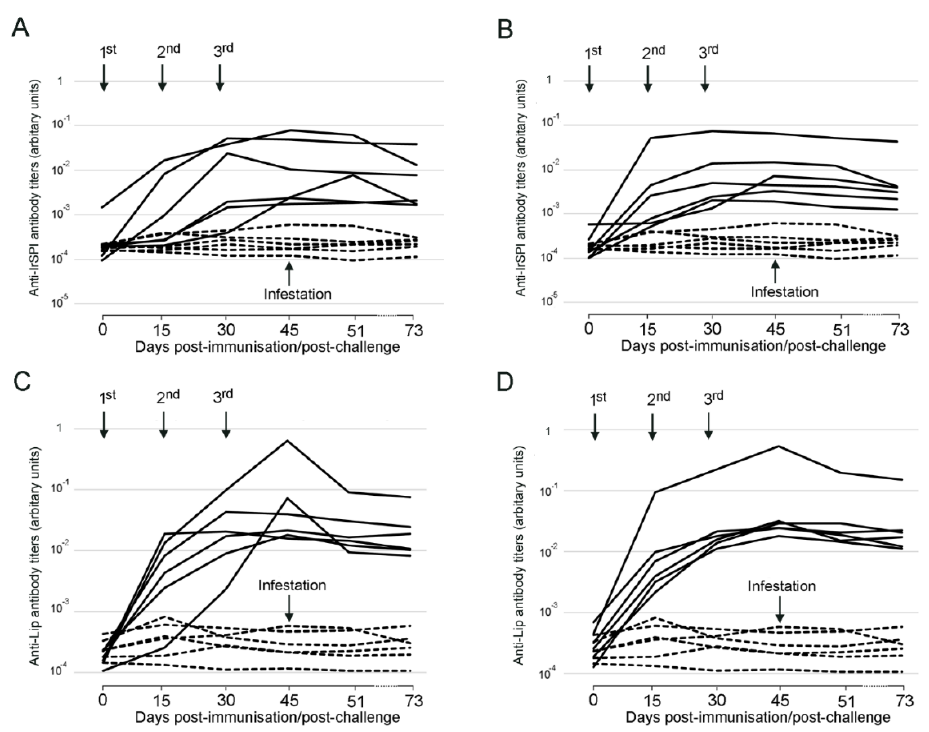
Figure 3. Antibody (immunoglobulin G, or IgG) response to recombinant IrSPI ( A , B ) and IrLip1 ( C , D ) in sheep vaccinated with recombinant IrSP1 ( A ), recombinant IrLip1 ( C ), or both recombinant IrSPI and Lip ( B , D ). Antibody titers were determined by ELISA in serum samples collected at different time points from Day 0 to Day 73 against the specific protein both in vaccinated sheep (solid lines) and control sheep (dashed lines) that received only adjuvant. Arrows indicate dates for 1st, 2nd, and 3rd immunizations (days 0, 15, and 30) and tick infestations (Days 45, 46). Antibody titers are represented as arbitrary units. E ff ect of vaccination of mice with recombinant IrSPI and IrLip1 proteins on tick infestation